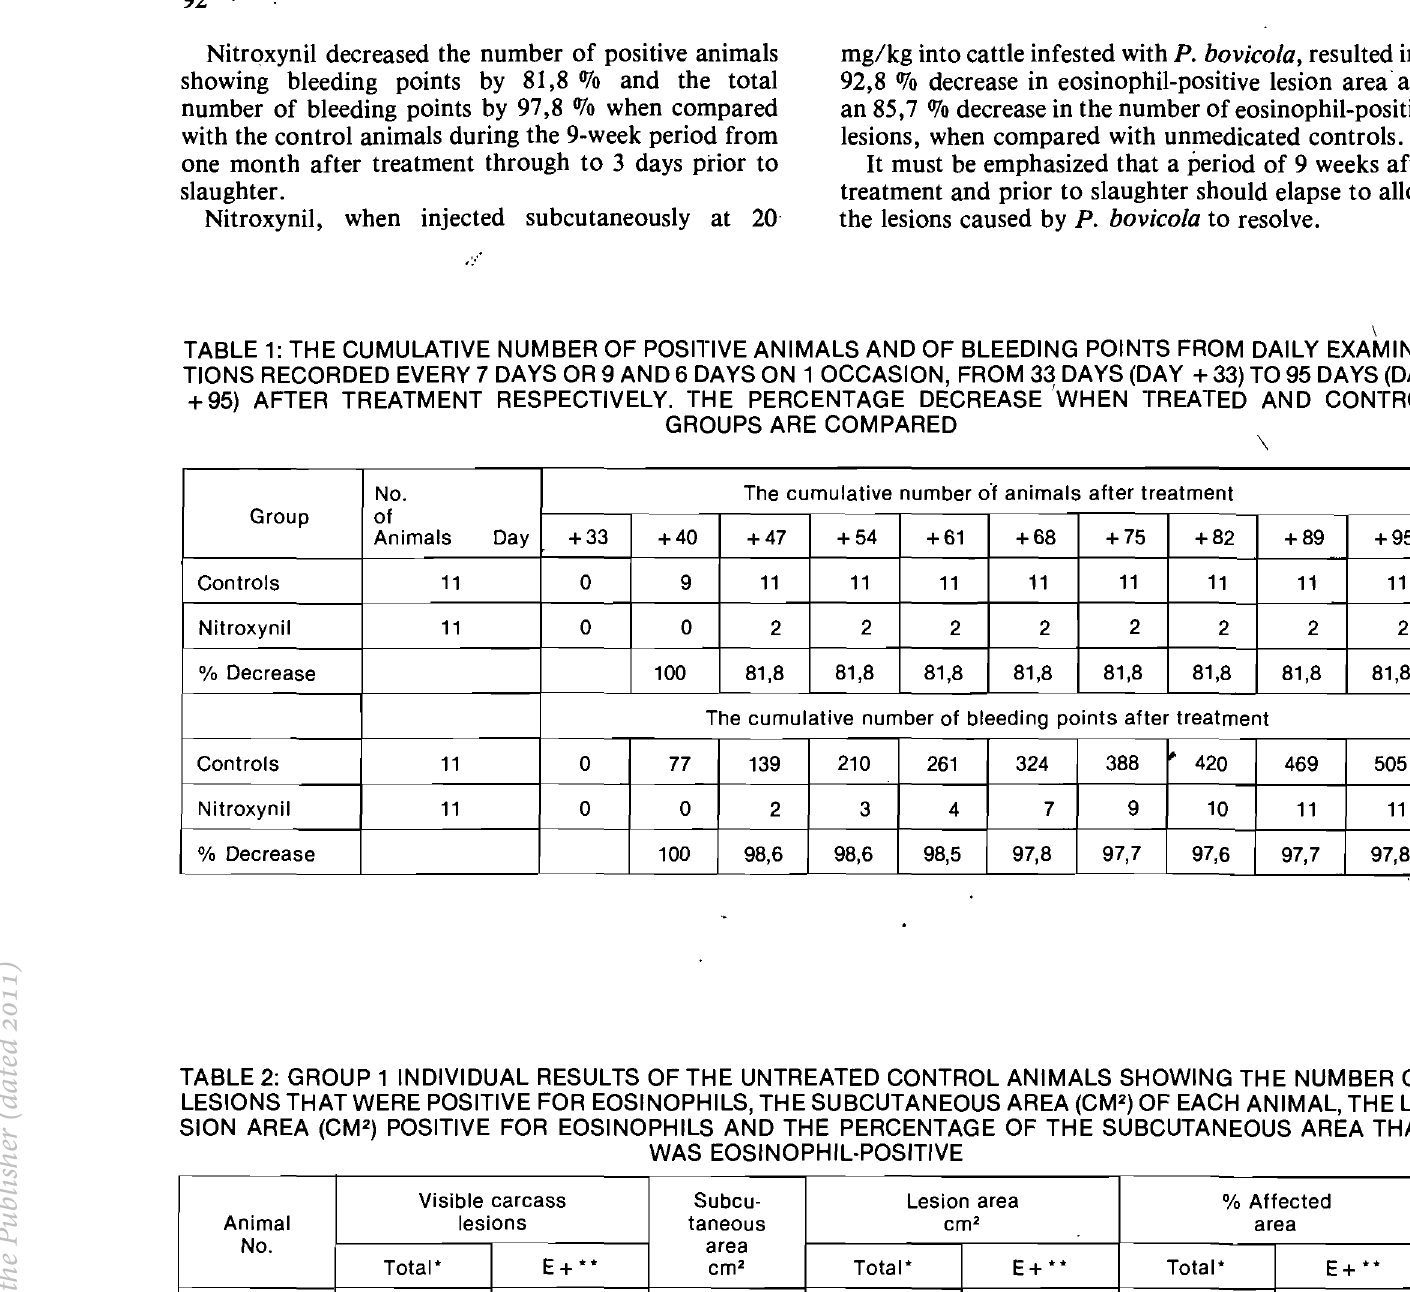
TABLE 1: THE CUMULATIVE NUMBER OF POSITIVE ANIMALS AND OF BLEEDING POINTS FROM DAILY EXAMINA-